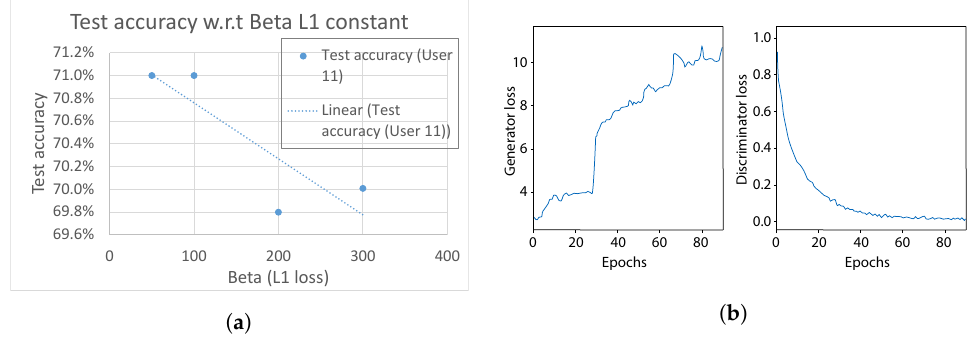
Figure 18. Effect of L 1 loss. ( a ) Generator L 1 β constant w.r.t test accuracy. ( b ) Comparison between generator and discriminator losses during training, when β = 50.